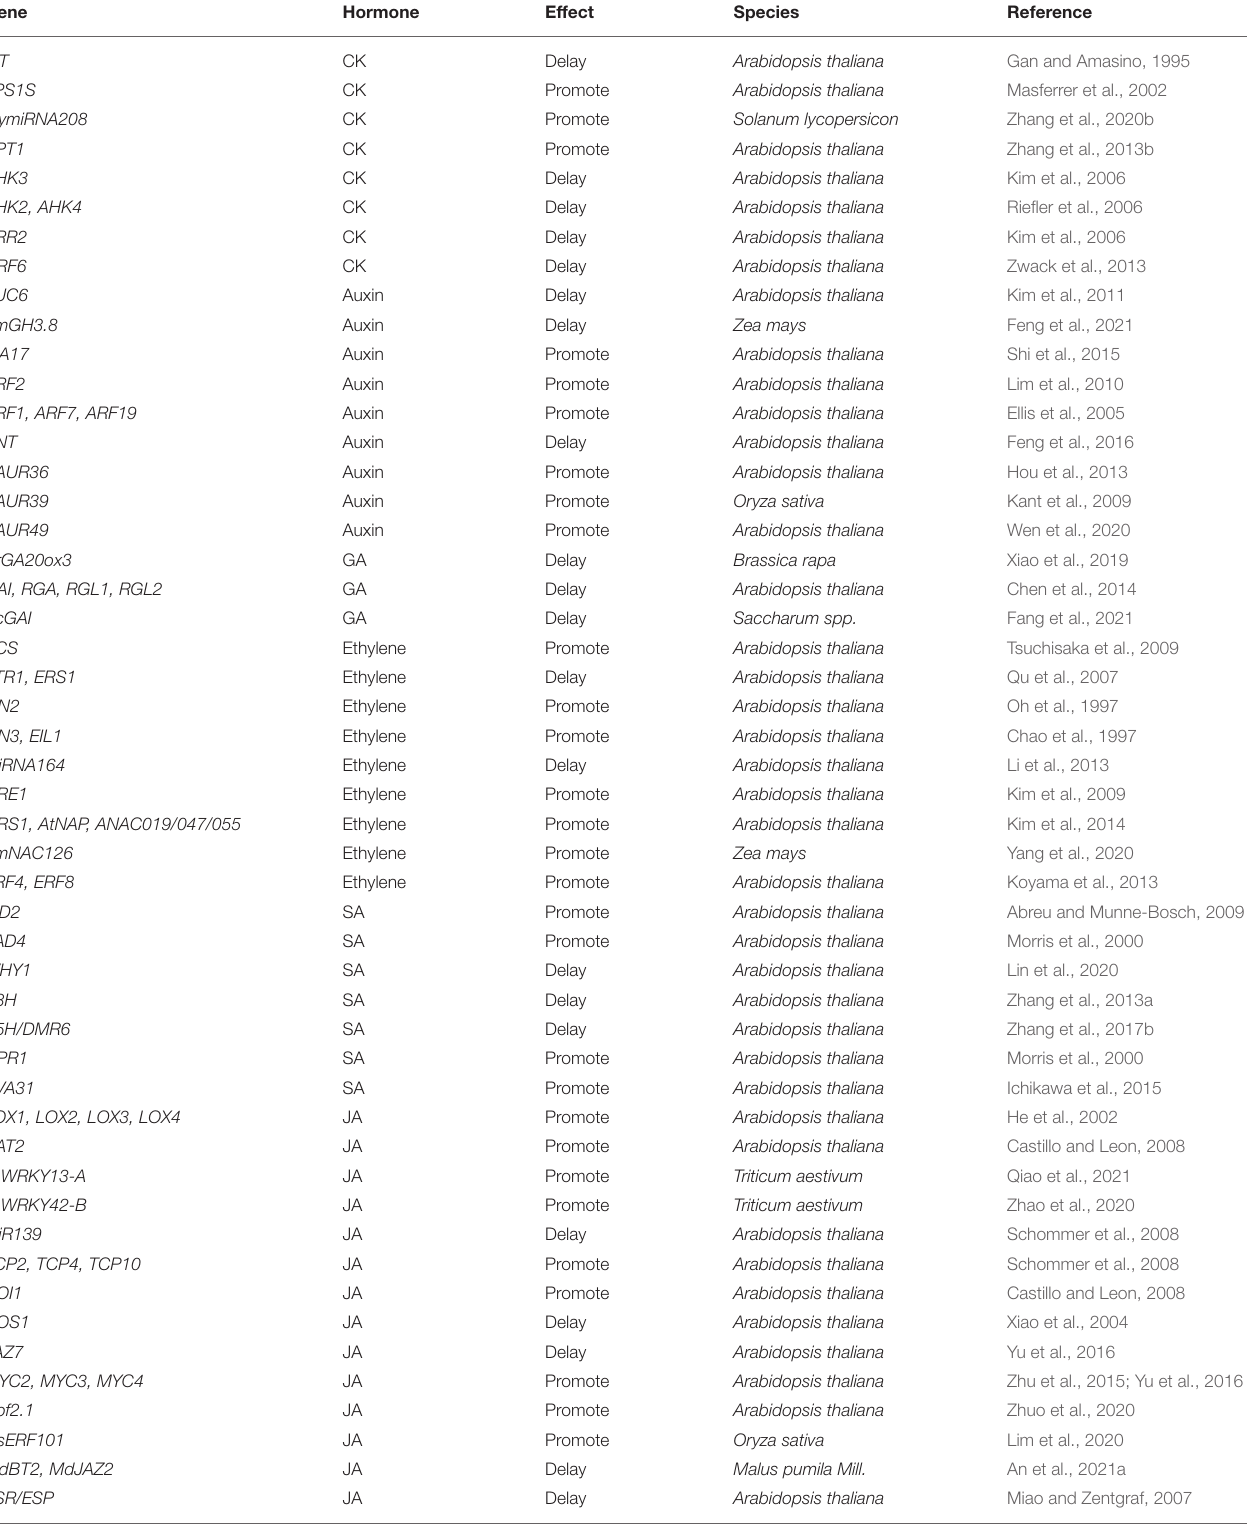
TABLE 1 | List of the key components in hormone pathway involved in leaf senescence.